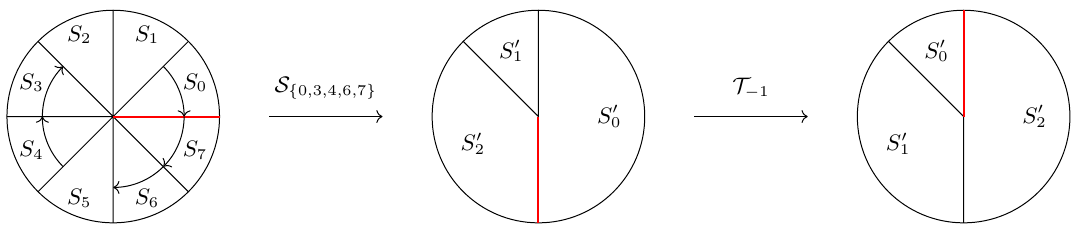
Figure 4 . Pictorial representation of the action of R (2 , (1 , 3 , 4)) on boundary conditions. The flow maps B (1 , 2) 7→ B (1 , 0) , B (1 , 5) 7→ B (1 , 1) , and B (1 , 1) 7→ B (1 , 2) . All other boundary conditions are anni- UV IR UV IR UV IR